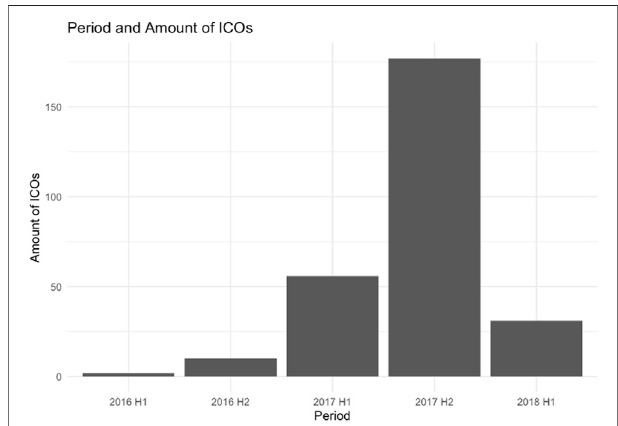
FIGURE 2 | Number of ICOs from 2016 to the fi rst half of